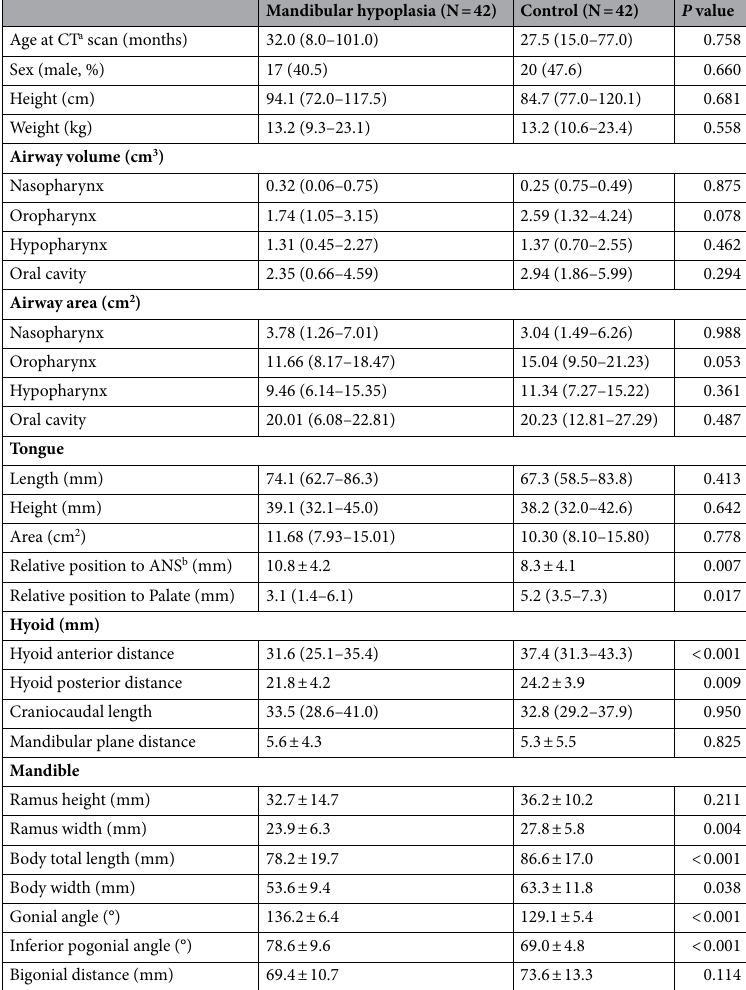
Table 1. Clinical characteristics and three-dimensional computed tomographic measures of the upper airway between the mandibular hypoplasia and control groups. Values are mean ± (standard deviation) or median (interquartile range). a CT Computed tomography. b ANS Anterior nasal